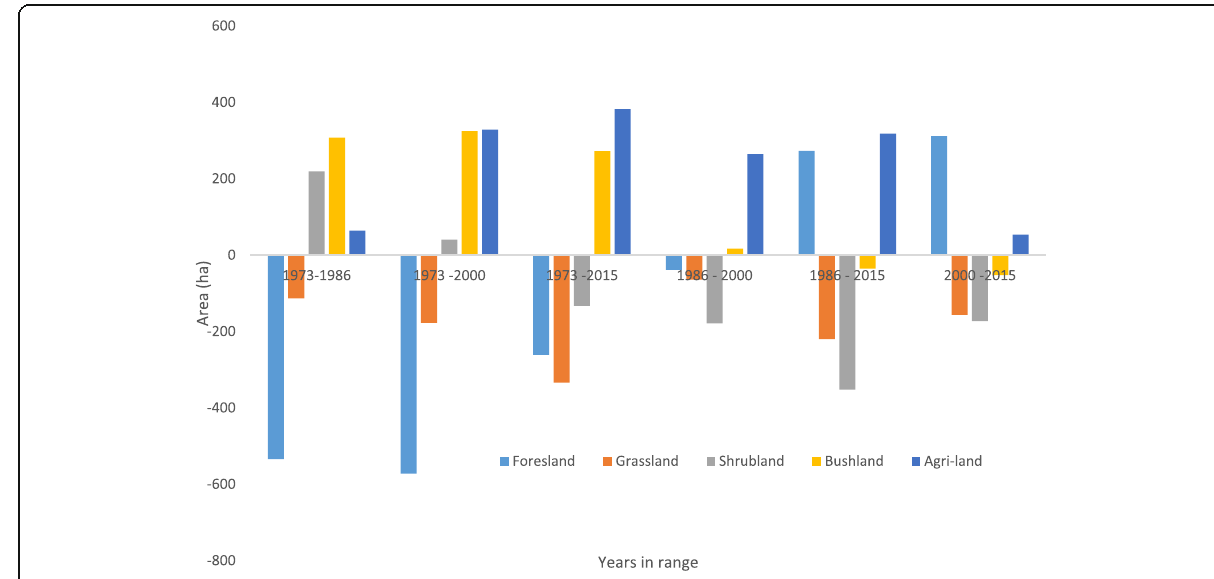
Fig. 7 Area of land cover changes (in ha) and % increase or decrease for the different reference years in Sidama, southern